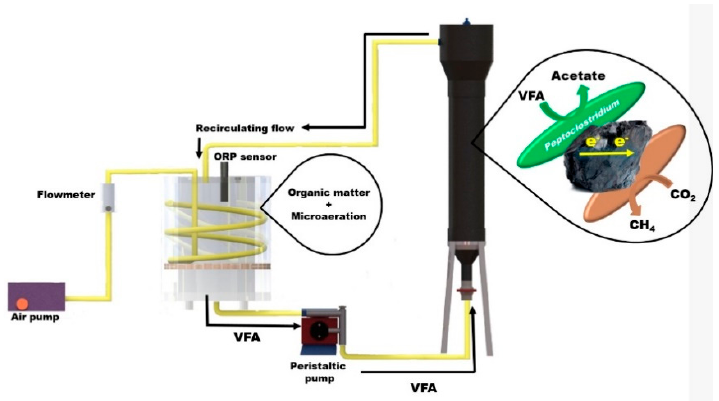
Figure 1. Reactors coupling system; packed bed reactor with micro-aereation and upflow anaerobic sludge blanket.